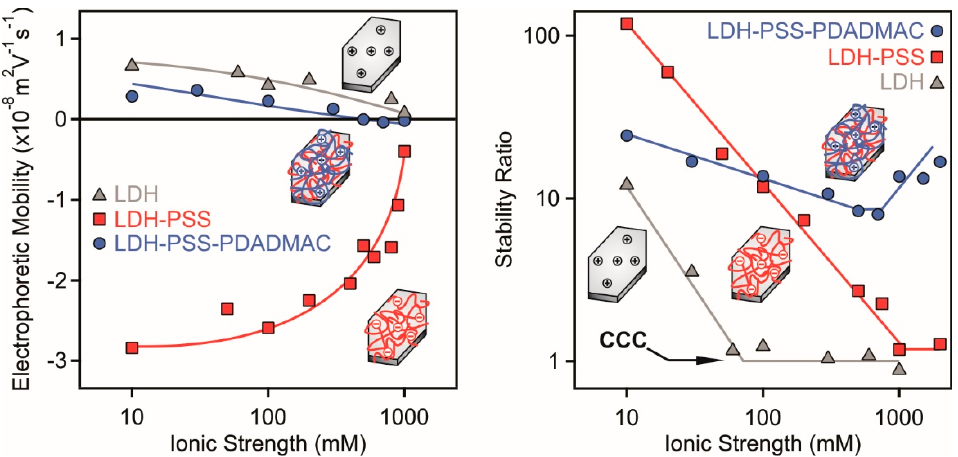
Figure 5. Electrophoretic mobility (left) and stability ratio (right) of bare LDH (triangles), LDH-PSS (squares) and LDH-PSS-PDADMAC (circles) particles versus the ionic strength adjusted by NaCl. A PSS dose of 100 mg/g and PDADMAC of 300 mg/g was applied in the composite particles. These doses correspond to the onsets of the ASP. The insets illustrate an LDH particle and its polyelectrolyte-functionalized derivatives.